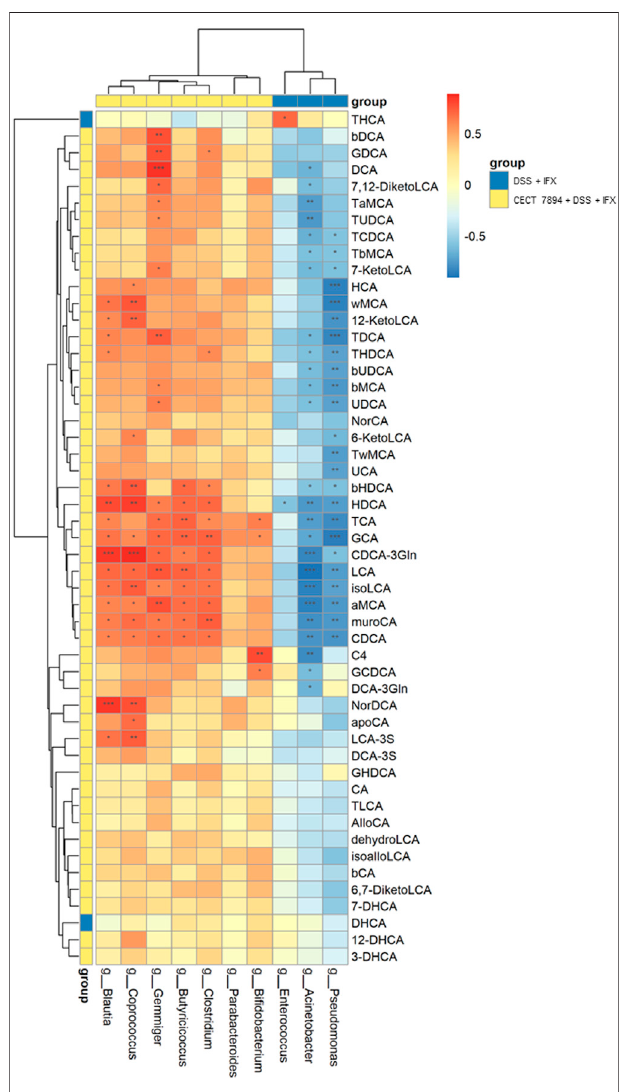
FIGURE 7 | Correlations among the fecal microbiota and fecal BAs. Spearman correlation analysis were performed between top 10 signi fi cant differences of bacteria genera and BAs between the DSS + IFX group and B. longum CECT 7894 + DSS + IFX group. Blue color represents negative correlations, and red indicates positive correlations. * p < 0.05, ** p ≤ 0.01, *** p ≤ 0.001.